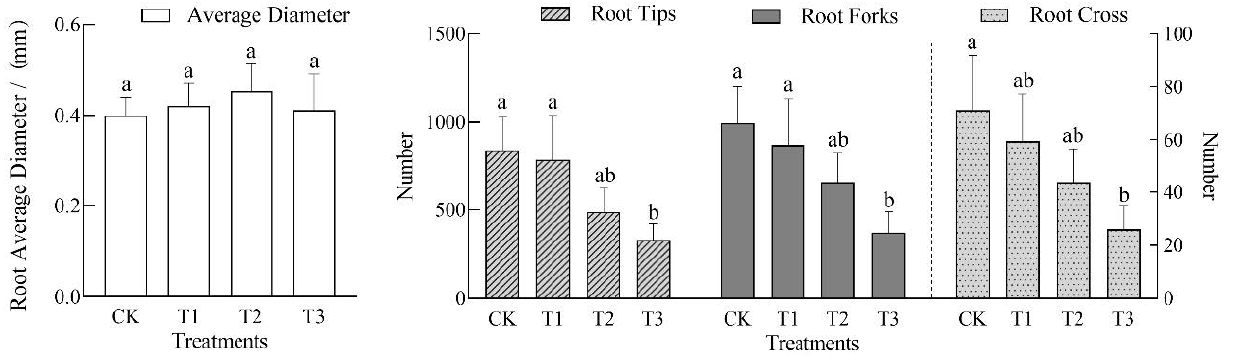
Figure 4. Effects of different treatments on the root average diameter, and numbers of root tips, forks, and crosses.